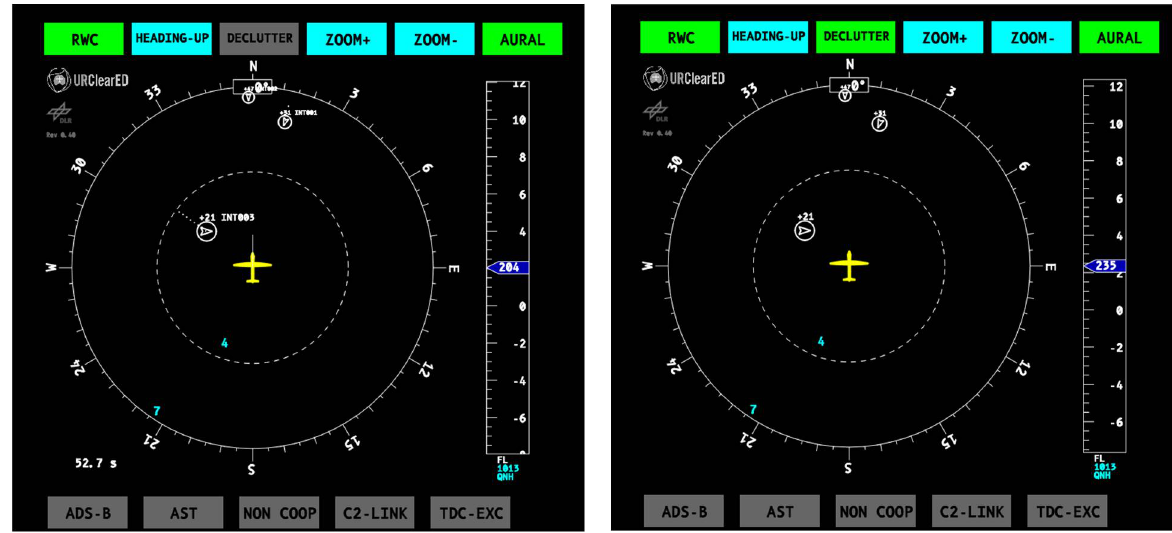
Figure 13. Display in cluttered and decluttered mode.